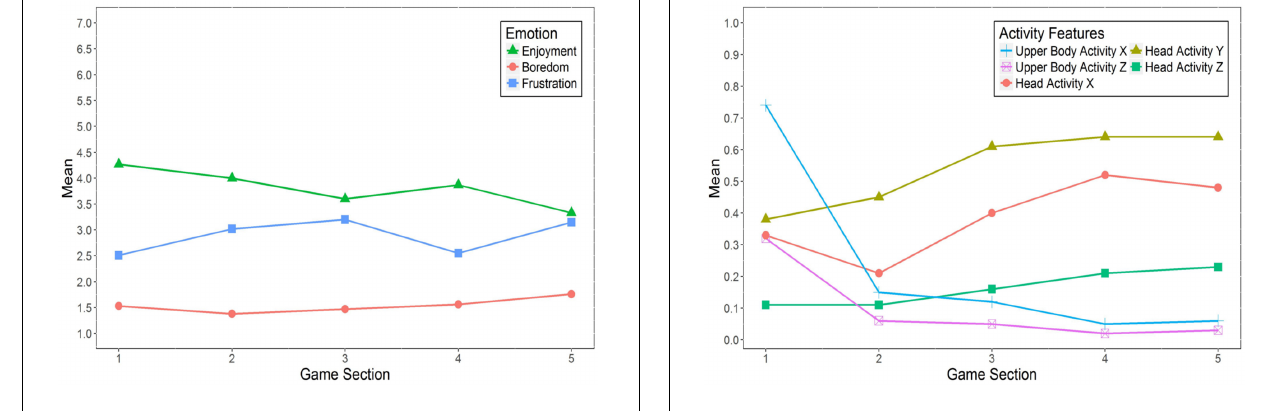
FIGURE 4 | Changes in emotional experience during playing Cure Runners . n = 55.